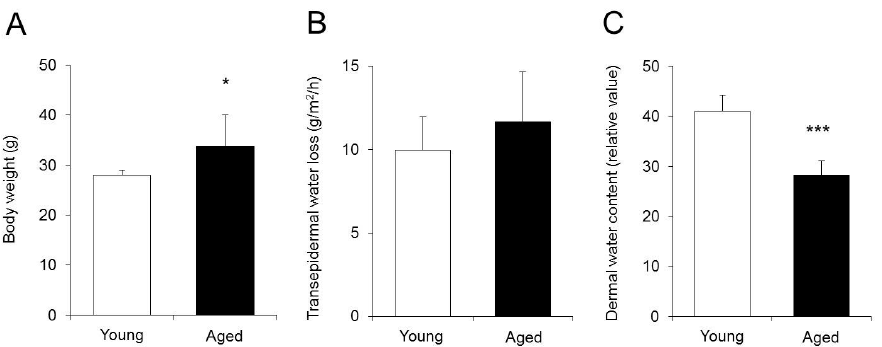
Figure 1. Body weight, transepidermal water loss (TEWL), and dermal water content. Young and aged mice had their body weight ( A ); TEWL ( B ); and dermal water content ( C ) measured. The data represent the means ± SDs for five mice. Student’s t -test: * p < 0.05 and *** p < 0.001 vs. Young mice.